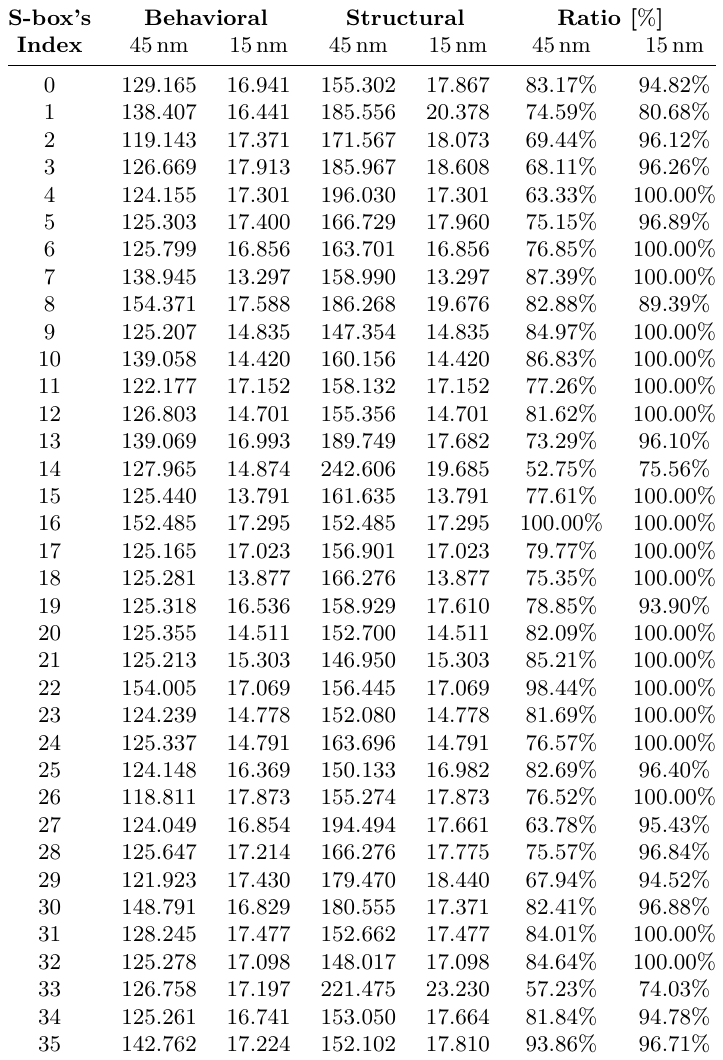
Table 8: Latency of the circuits for 7-bit quadratic S-boxes used in Example 5 using behavioral and structural modes of implementation in NanGate 15 nm and 45 nm